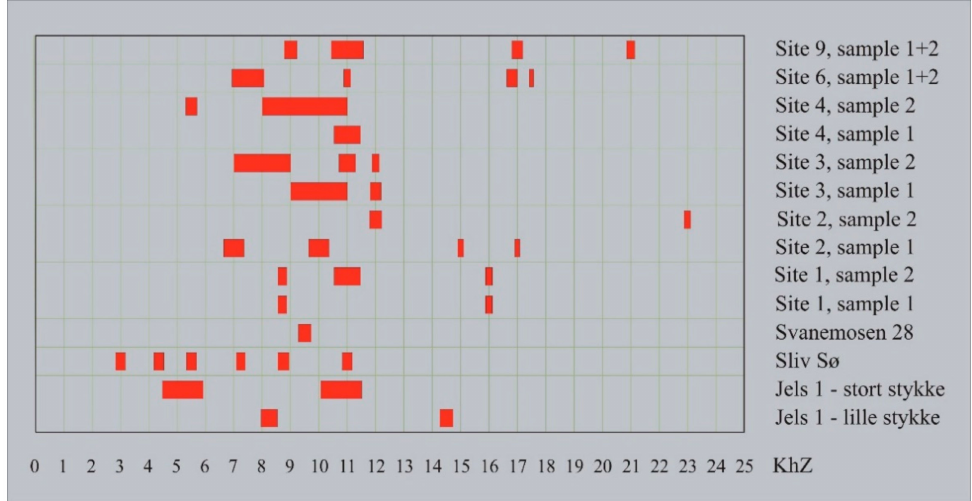
Figure 2. The resonance frequency peaks of Mesolithic and Late Palaeolithic flint blades measured in the Bang & Olufsen Sound Laboratory. The two upper measurements each represent two separate blades. Measurements by Hugo Rasmussen 1982. Graphic: